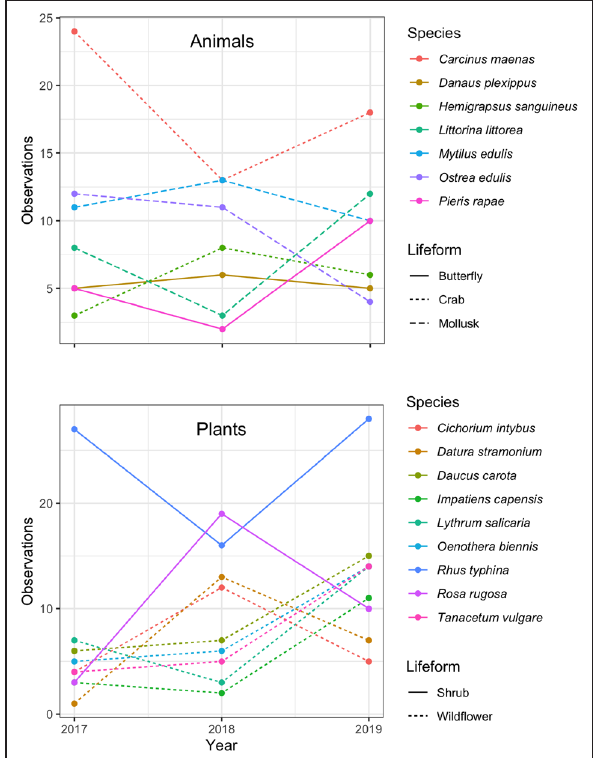
Figure 4 The most common species and life forms of animals and plants found across three years of sampling. Year-to-year variation in the types of organisms the students documented is large. Across the years, crabs, mollusks, and butterflies were common among animals and shrubs, and wildflowers were common among